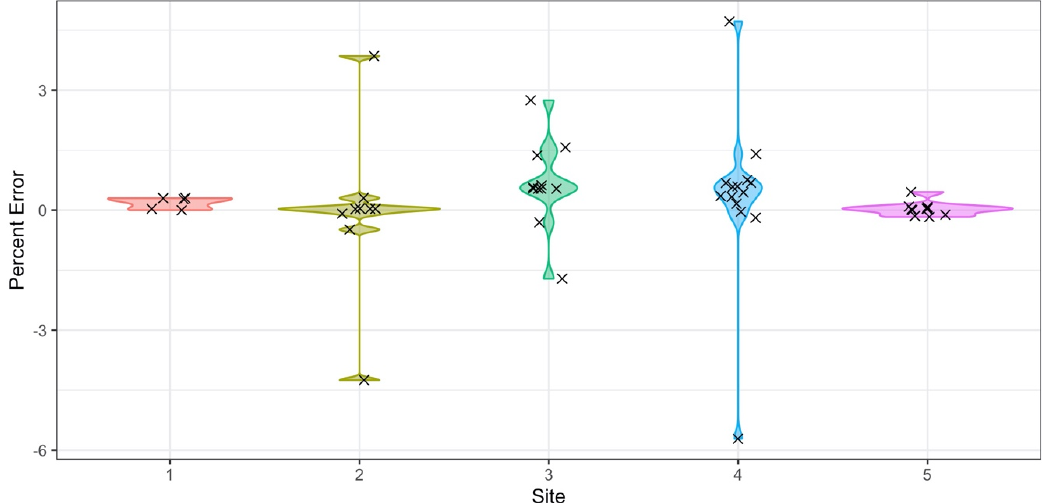
Figure 8. Percent difference between the volume registered by the meter (calculated as the difference between two consecutive, manual readings of the meter’s register) and the volume registered by the CIWS datalogger (calculated as the number of observed pulses multiplied by the pulse resolution of the meter) for multiple deployment periods at each experimental site. The points in the figure represent individual percent errors computed for every field visit at each site. Values have been spread across the x axis for visualization purposes. The number of deployment periods was 5, 9, 11, 14, and 10 for each site.